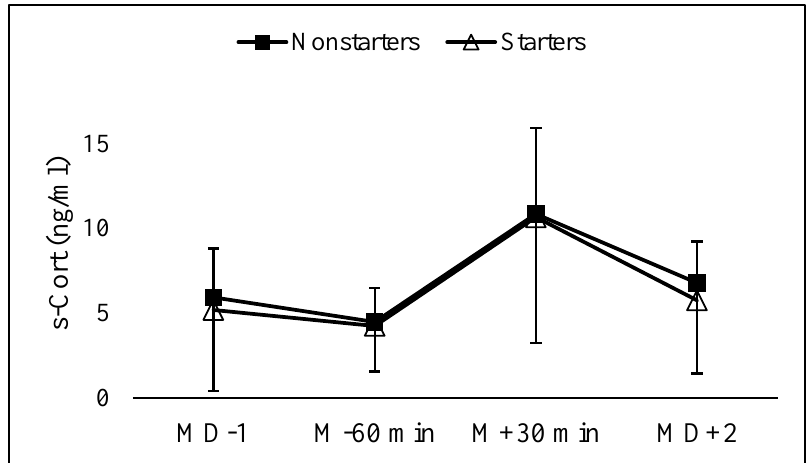
Figure 2. Mean and SD values of s-Cort the day before the match (MD − 1), 60-min before kick-off (M − 60 min), 30-min post-match (M + 30 min), and 48-h post-match (MD + 2). Table 1. Effects of playing time and physical performance on s-IgA differences calculated between 30-min post-match and 60-min before kick-off time points.